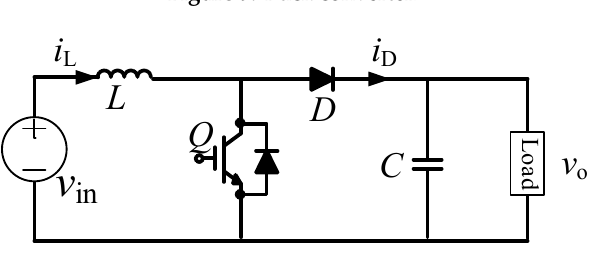
Figure 9. Buck converter.